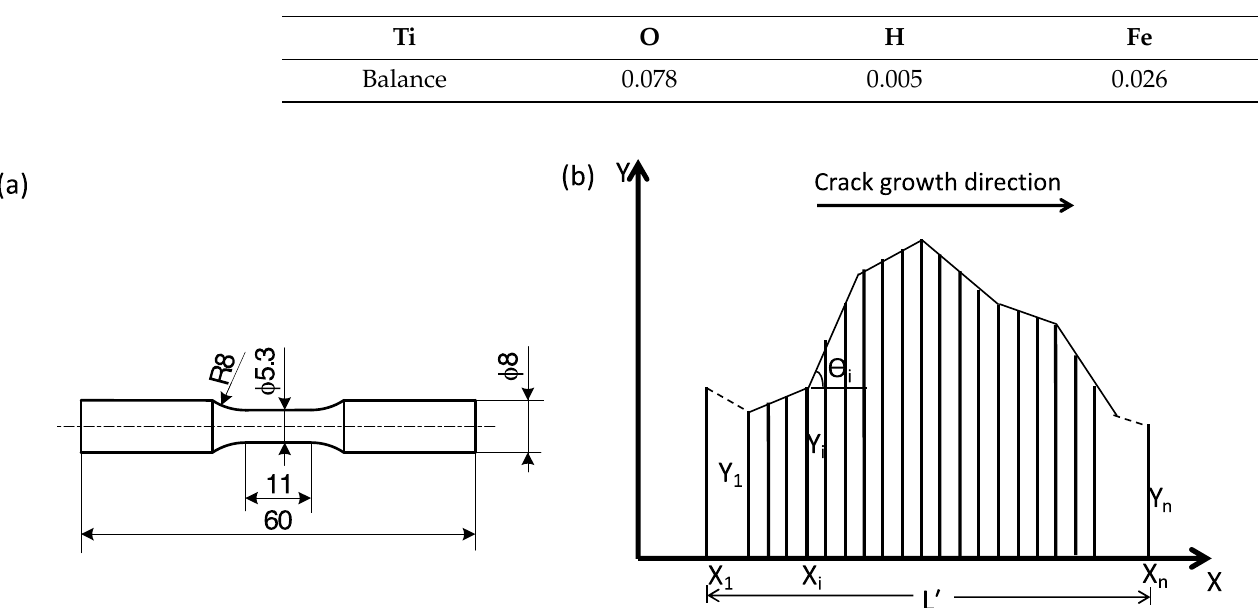
Figure 1. ( a ) Schematic of sample with the dimensions used for the rotating bending test (dimensions in mm); ( b ) Y- coordinates along the crack path profile with equidistant spacing.